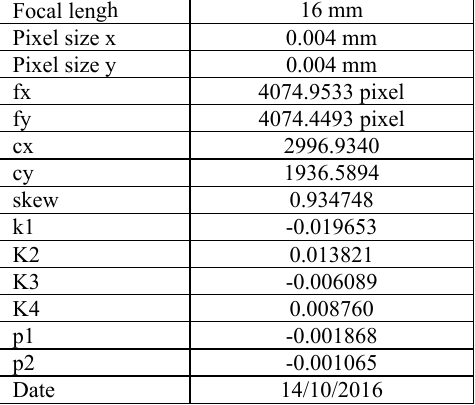
Table 1: Calibration parameters of the camera